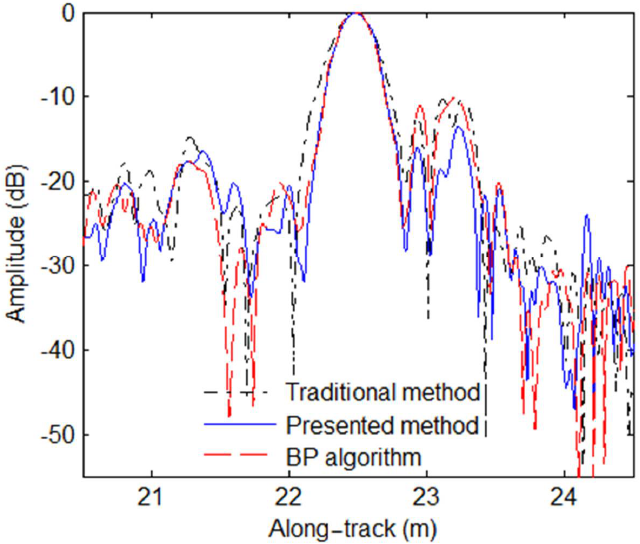
Figure 21. Along-track slices of target marked by a red arrow in Figure 20a.